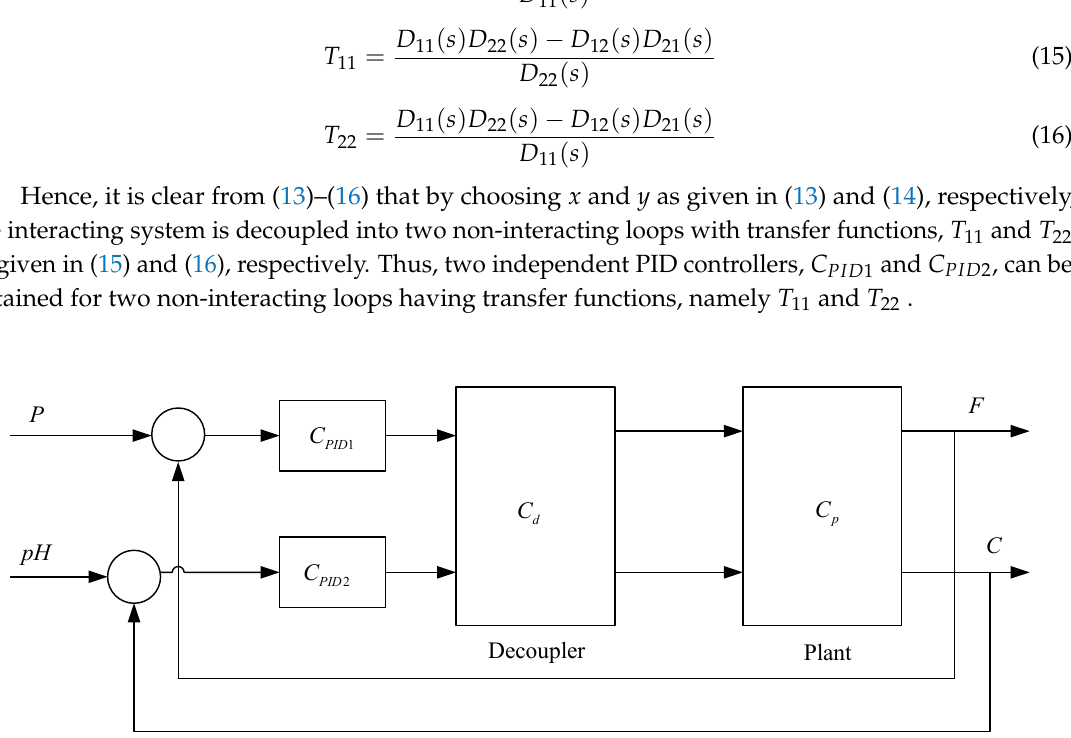
Fig. 3. Decoupler with TITO system. Figure 3. Decoupler with TITO